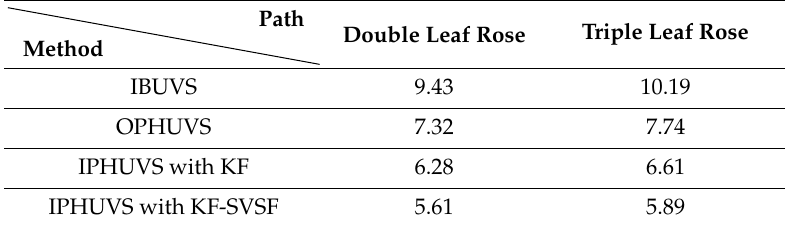
Table 6. MSE of di ff erent strategies in the dynamic tracking experiment. Table 6. MSE of different strategies in the dynamic tracking experiment.